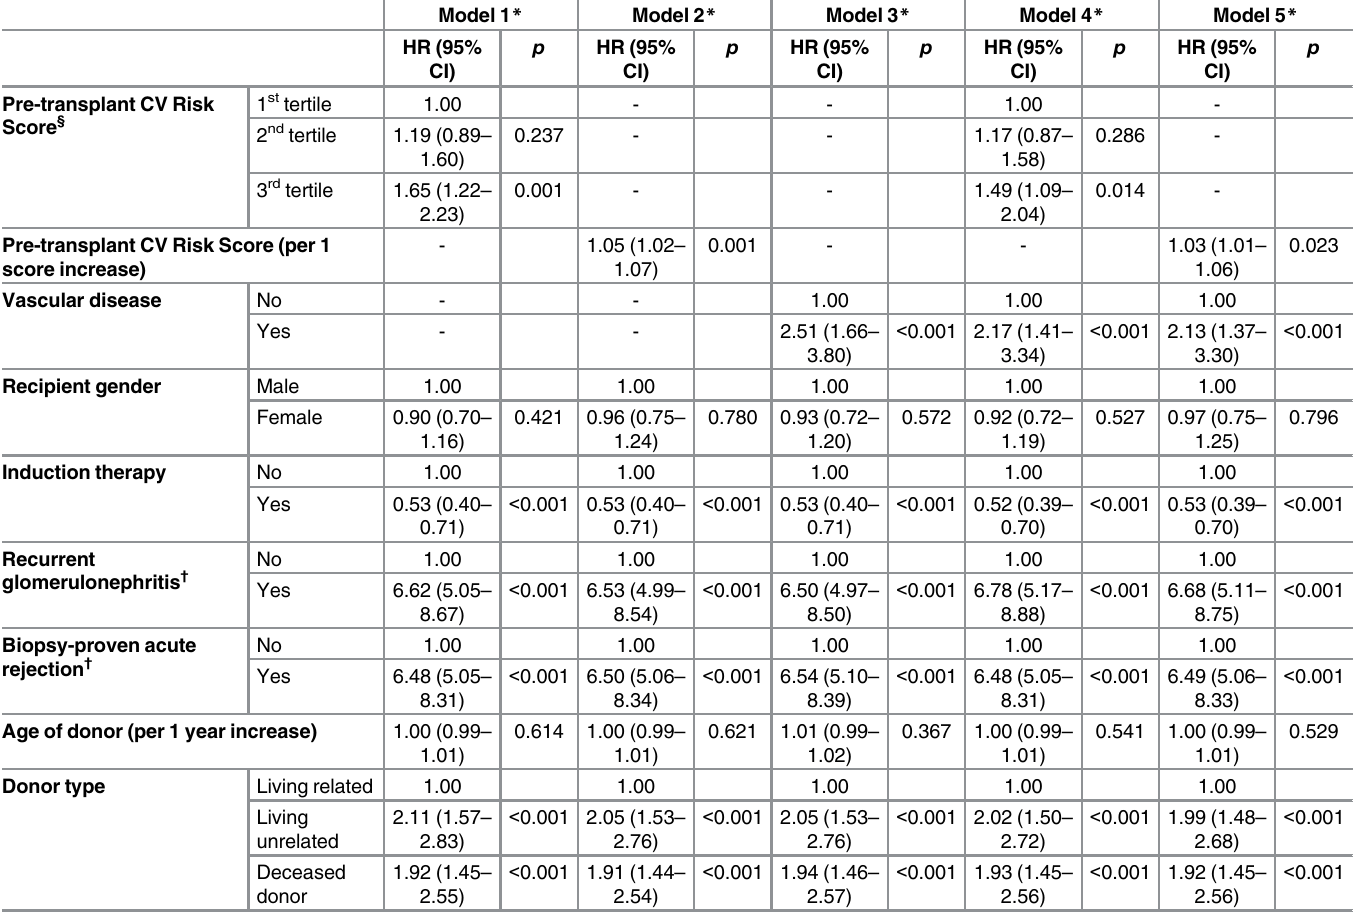
Table 3. Hazard ratios for allograft failure according to baseline risk factors in 2,902